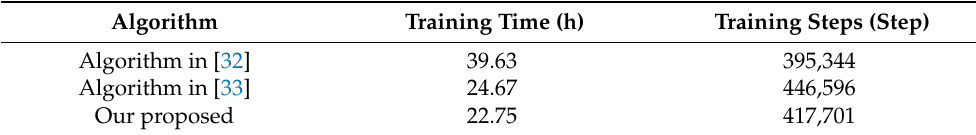
Figure 14. Average reward returned by reference [32,33] and our proposed algorithm every 10,000 steps during training in simulation Figure 6a. Table 7. Comparison of training time and steps of each algorithm in simulation Figure 6a.